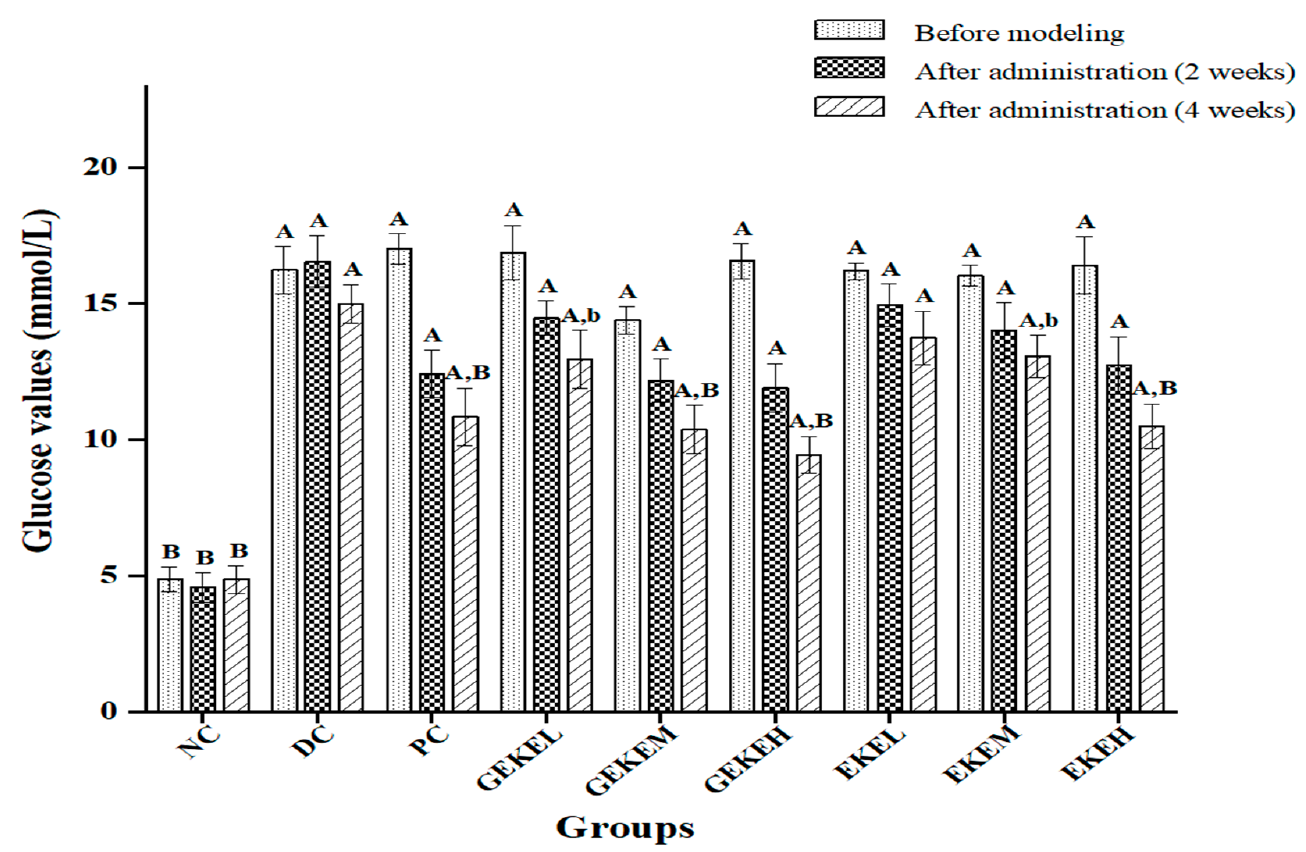
Figure 2. Effect of Gordon Euryale seed kernel extract (EKE) and germinated Gordon Euryale seed